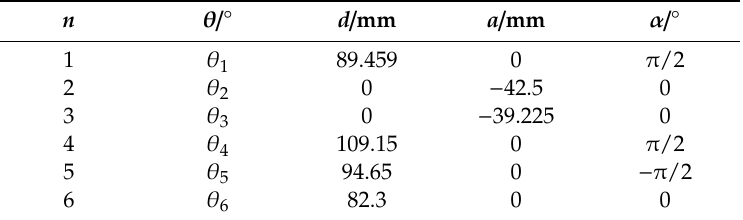
Table 3. Denavit–Hartenberg (DH) parameters of the KingKong collaborative robot. n θ / ◦ d / mm a / mm α / ◦ 1 θ 1 89.459 0 π /2 2 θ 2 0 − 42.5 0 3 θ 3 0 − 39.225 0 4 θ 4 109.15 0 π